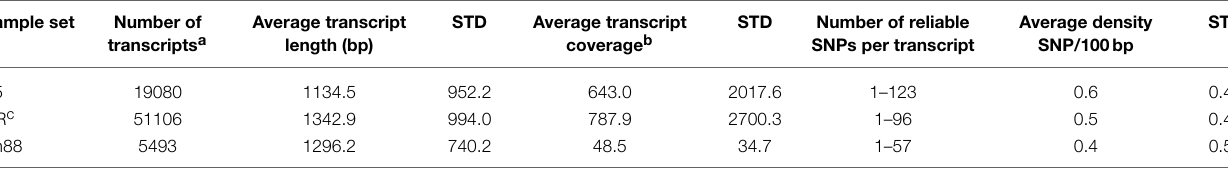
TABLE 2 | Number of SNPs mined in the three rose datasets. Sample set